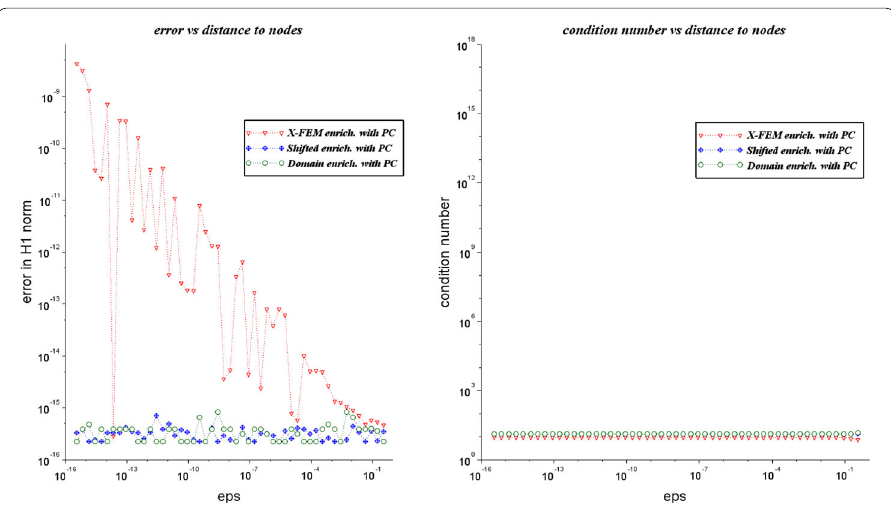
Fig. 11 The use of dedicated pre-conditioners improves the condition number but has little effect on X-FEM accuracy. According to the curves above, conditioning and accuracy are clearly two separated issues: improving the condition number does not automatically solve accuracy issues. Conditioning and